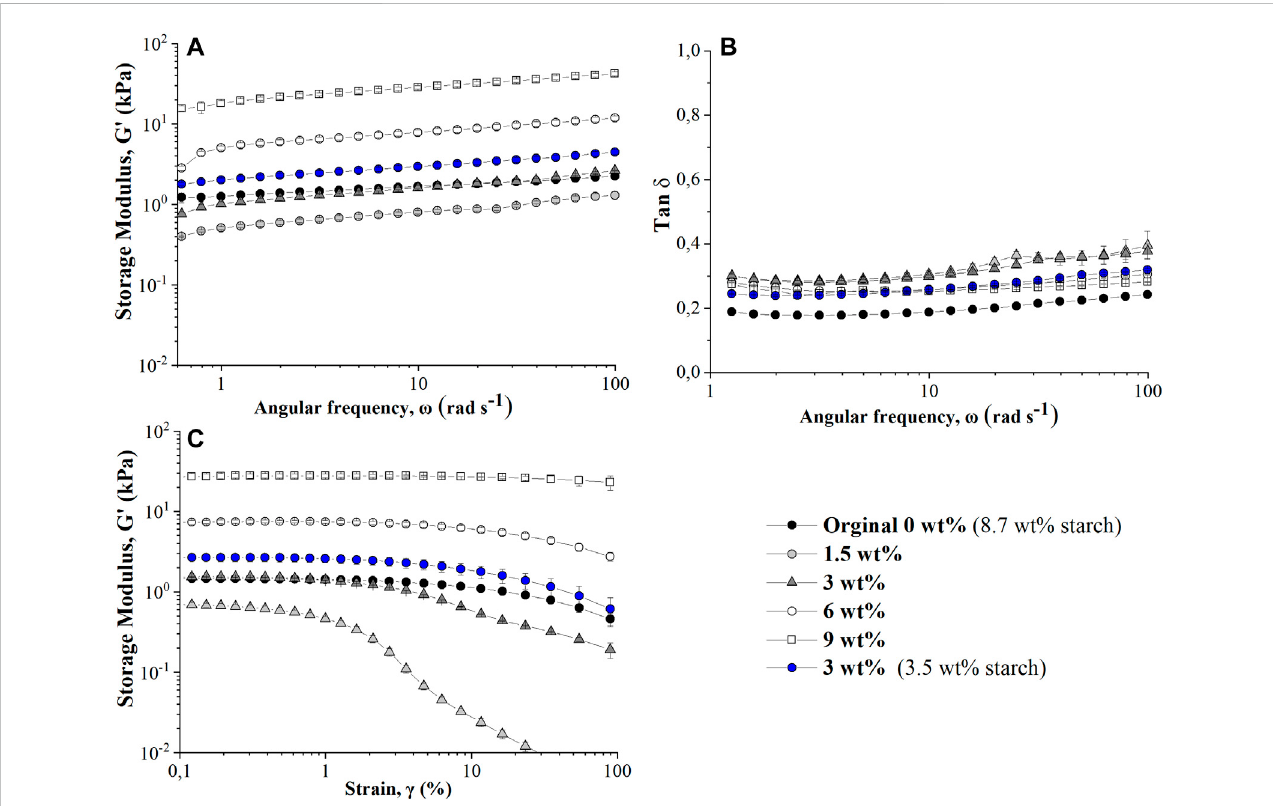
FIGURE 3 Characterization of the viscoelastic properties with regards to the different formulations (A) storage modulus (kPa) vs. angular frequency (B) tan δ vs. angular frequency (C) storage modulus (kPa) vs. strain (%).